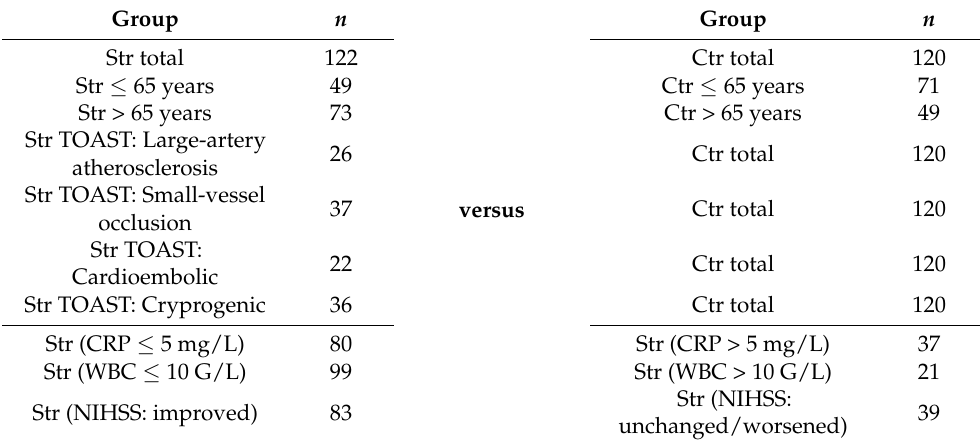
Table 3. Study groups and subgroups used for statistical comparisons of genotyping